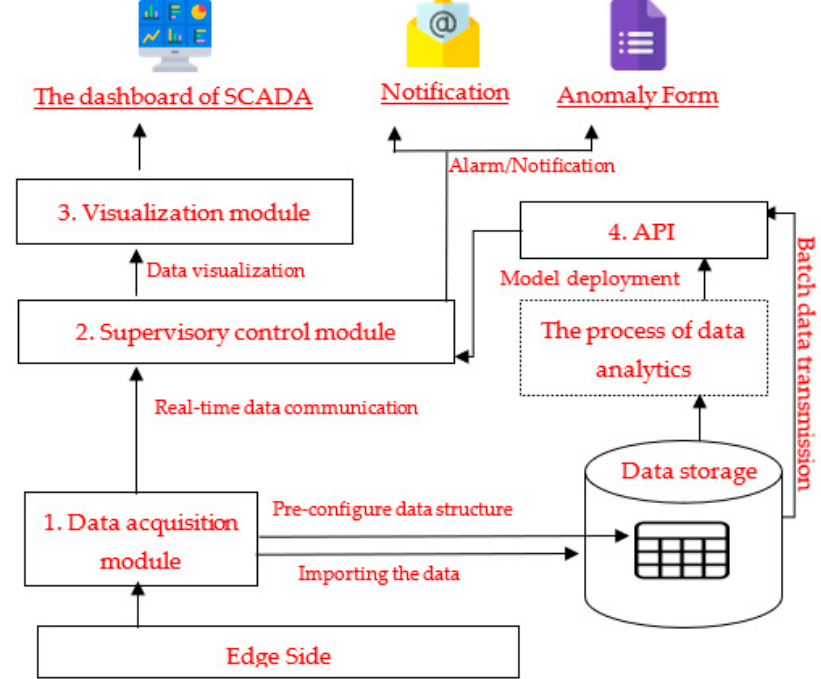
Figure 6. The structure of the proposed CAADS system.